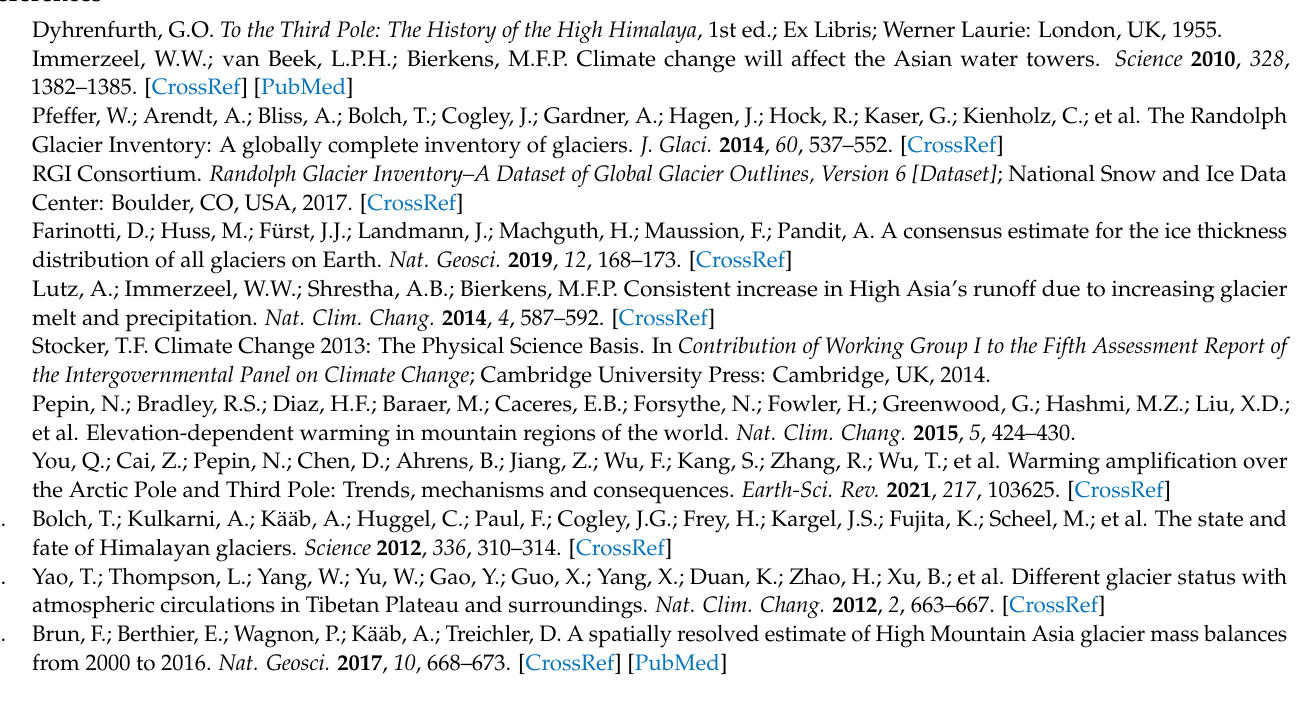
Figure S8: The annual mean snow cover (a) and monthly mean snow cover (b) at Kyanjing River basin; Figure S9: The annual mean snow cover (a) and monthly mean snow cover (b) in the Tuole River station; Table S1: List of model parameters and their initial ranges; Table S2: The optimal model parameter combinations for the configurations in the Kyanjing River basin; Table S3: The optimal model parameter combinations for the configurations in the Tuole River